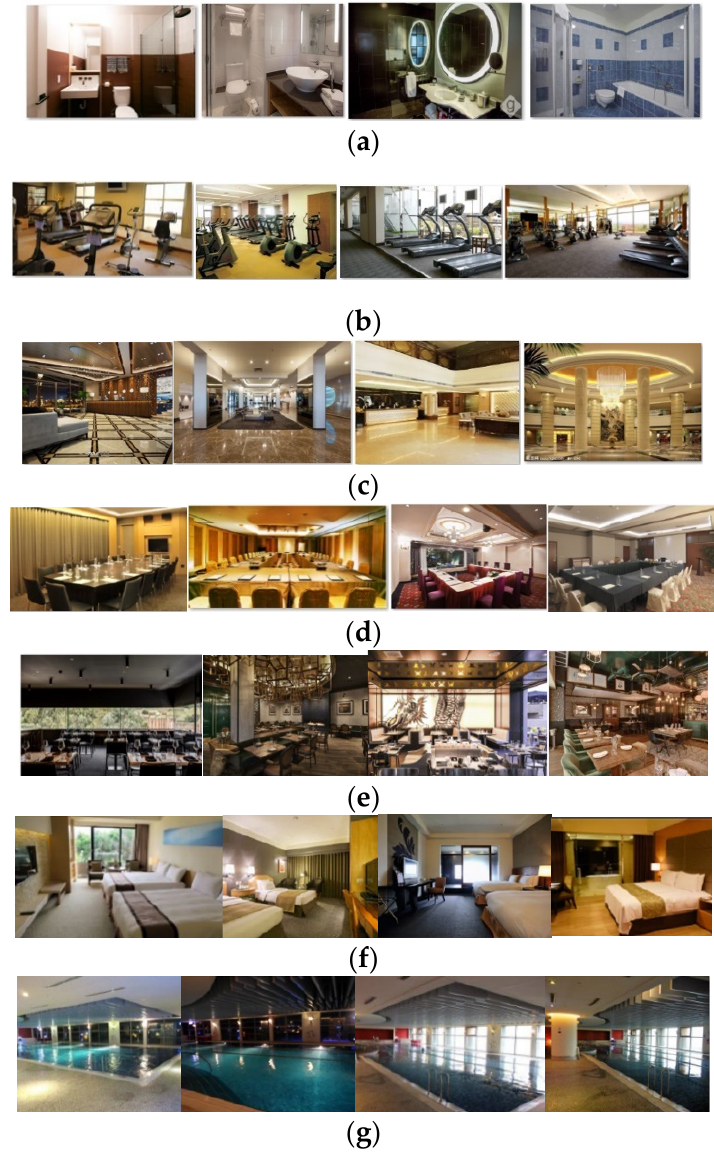
Figure 6. Examples of training images for hotel scene classification: ( a ) bathroom; ( b ) gym; ( c ) lobby; ( d ) meeting room; ( e ) restaurant; ( f ) room; ( g ) swimming pool.